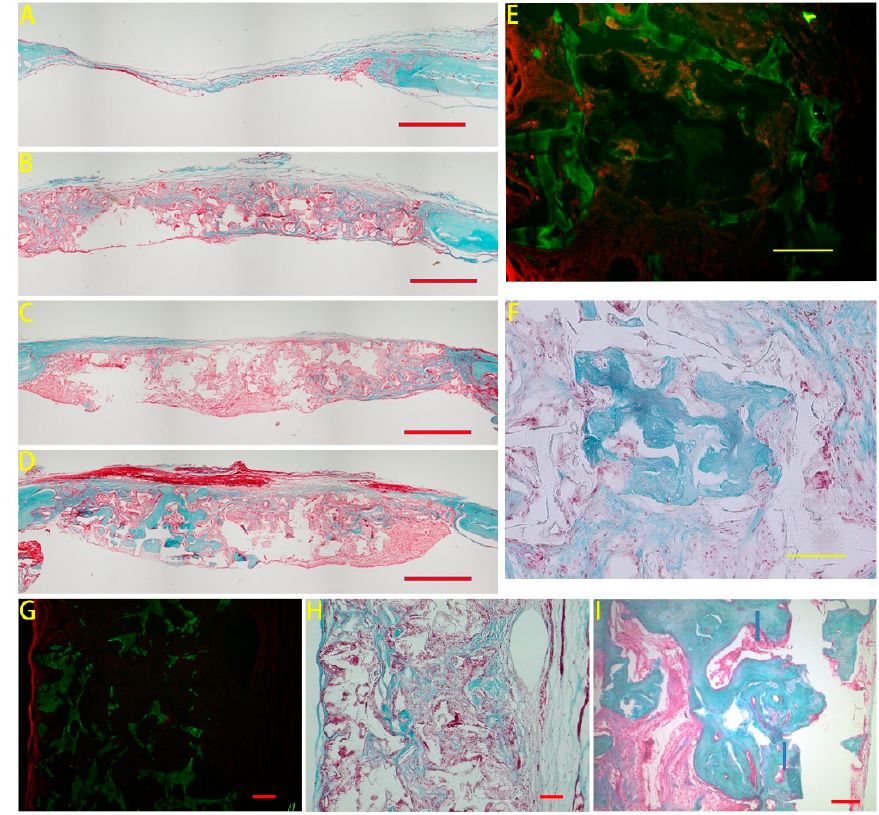
Figure 1. Masson’s trichrome staining results. The overview from the empty group ( A ), the Scaf ‐ fold group ( B ), the BMSC group ( C ) and the CO group ( D ) was observed. Scale bar: 1mm. Newly formed osteoid (bluish green color areas) grew in the pores of the poly(LLA ‐ co ‐ DXO) scaffolds in the CO group ( F , H ). Scaffold images (green areas) were obtained by autofluorescence from the material ( E , G ). Blood vessels (indicated by blue arrows) were observed at the site of osteoid formation in the CO group ( I ). Scale bar: 100 μ m.